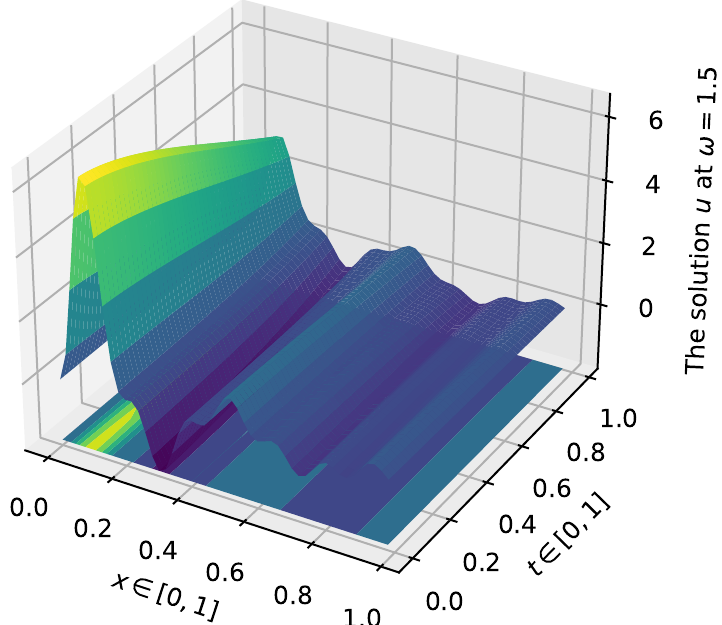
Figure 5. The 3-dimensional graph of solution u on the domain ( x , t ) ∈ [ 0,1 ] × [ 0,1 ] for ω = 1.5.